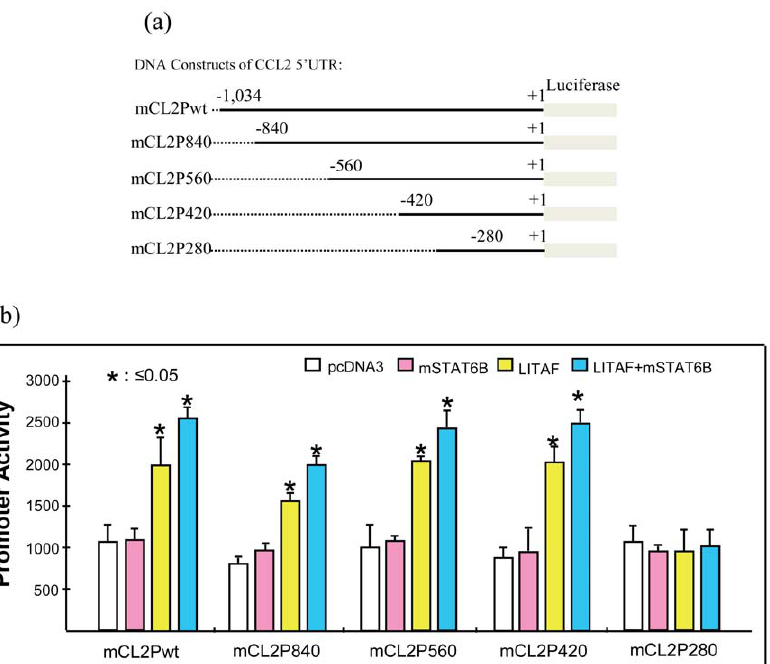
Figure 3. Effects of mSTAT6B and/or mLITAF on mouse CCL2 5 9 UTR&promoter-enhanced activity. (a) Diagram of DNA deletions of mouse CCL2 5 9 UTR&promoter region. The PCR-amplified DNA fragment of mouse CCL2 5 9 UTR&promoter in the region from 2 1034 , 1, 2 840 , 1, 2 560 , 1, 2 420 , 1, or 2 280 , 1 was respectively inserted into pGL3-basic plasmid as reporter DNAs (named mCL2Pwt, mCL2P840, mCL2P560, mCL2P420, or mCL1P280). (b) Raw264.7 cells were cotransfected with reporter DNAs of mCL2Pwt, mCL2P840, mCL2P560, mCL2P420 or mCL2P280 plus pcDNA3 as control (white bars), mLITAF (pink bars), mSTAT6B (yellow bars) or both mLITAF&mSTAT6B (blue bars) overnight. All test cells were cotransfected with 5 ng of b -gal DNA. The lysate from each test cells was assessed by luciferase assay. Triplicate assays were performed and their values were normalized according to b -gal production and graphed.